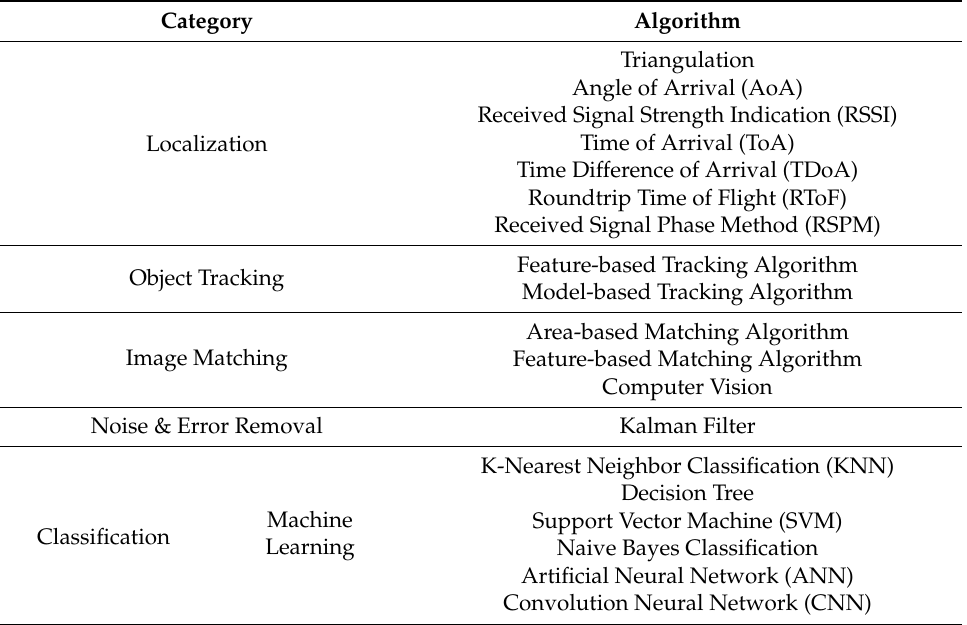
Table 3. Commonly-used algorithms to improve construction safety